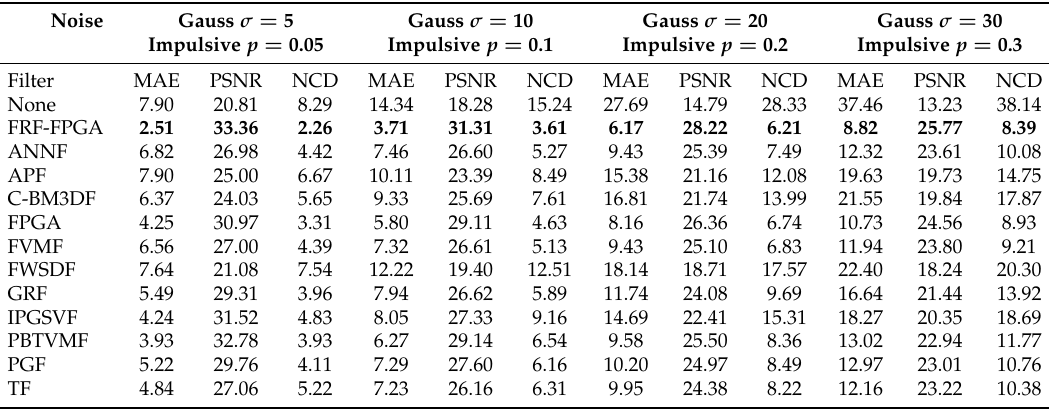
Table 3. Comparative study with state-of-the-art techniques. Parrots test image corrupted with various intensities of mixed noise. Bold values express the best restoration